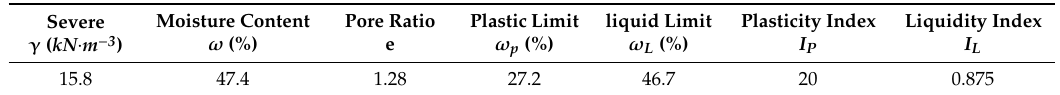
Table 2. The properties and index of the test soil.